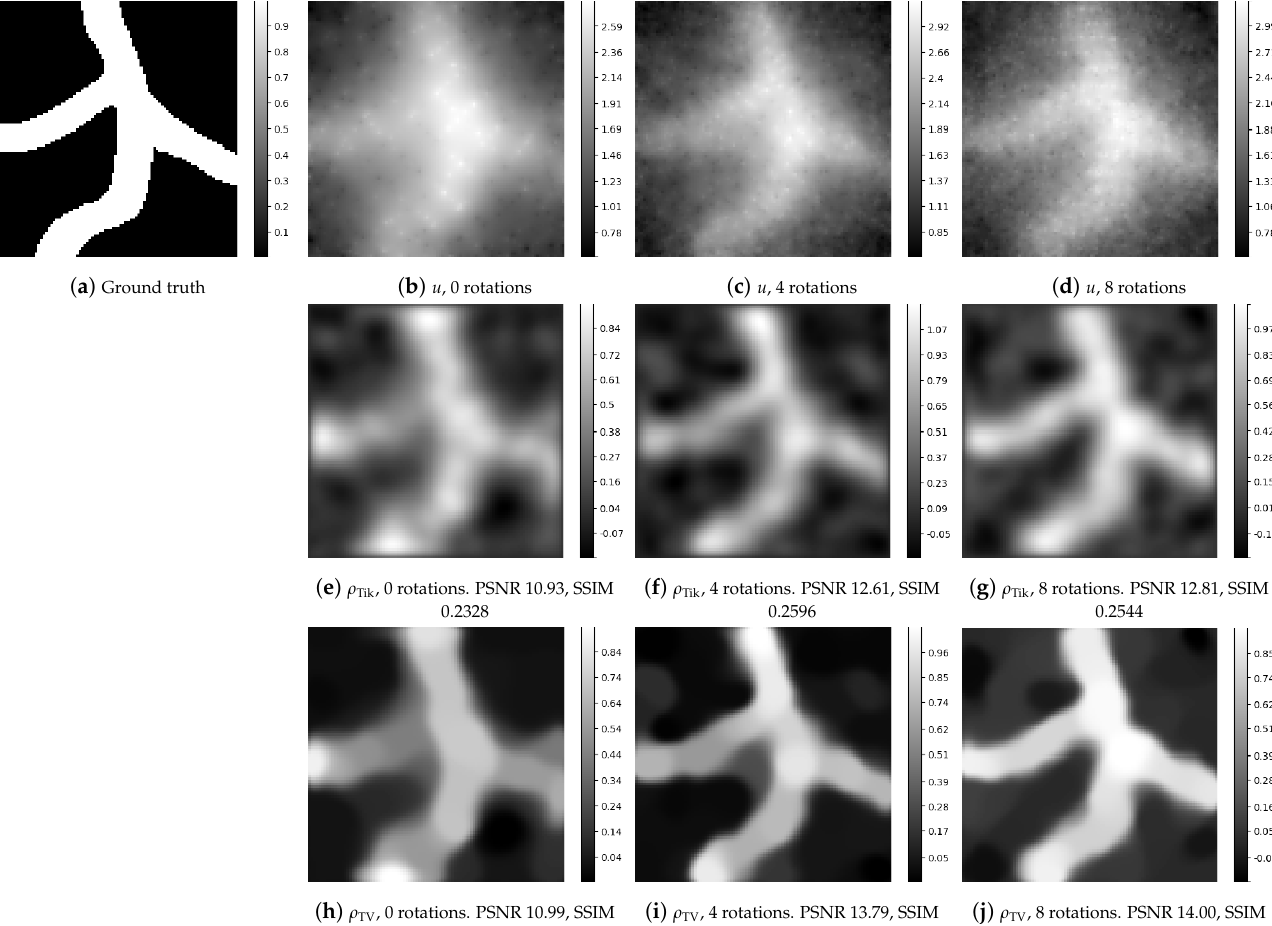
Figure 6. Reconstruction of a vessel-shaped phantom using model-based two-stage reconstruction for combining rotated scan trajectories. First row. Trace fields u = trace A [ ρ ] (output of Stage 1) obtained with increasing number of rotations 0,4,8. Second row. Reconstruction results ρ Tik using Tikhonov regularized deconvolution in Stage 2 with increasing number of rotations. Third row. Reconstruction results ρ TV using TV smooth regularized deconvolution in Stage 2 with increasing number of rotations. We observe qualitatively in the case of a more realistic phantom that merging rotated scans helps to enhance the quality of the reconstruction for both Tikhonov and TV type regularization. In particular, the locations of junctions become more distinctive with